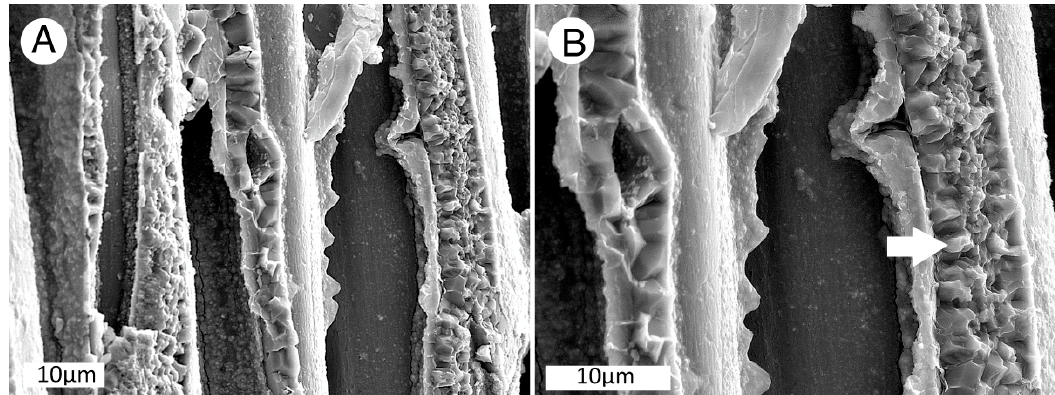
Figure 8. SEM images of Salitre specimen S1-A showing empty lumina. ( A ) Three adjacent tracheids with empty lumina; ( B ) The cell walls have been mineralized with microcrystalline quartz (arrow).